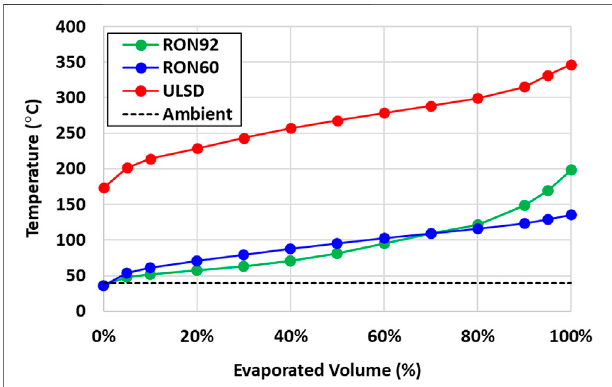
FIGURE 2 | Fuel distillation curves (ASTM D86) compared to non- evaporating ambient vessel